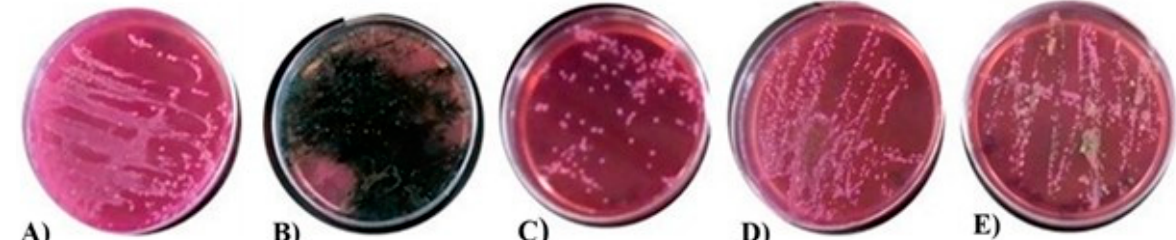
Figure 7. Reduction of growth SE PT13A in the cloacal samples obtained 48 h after the administration of the corresponding treatment. ( A ) Control group, uninfected and non-treated chickens; group ( B ) chickens infected with SE PT13A without treatment; group ( C ) chickens infected with SE PT13A and treatment with antibiotics; group ( D ) chickens infected with the bacteria and treatment with 1 g of beads containing phage; and group ( E ) chickens infected with SE PT13A and treatment with beads without